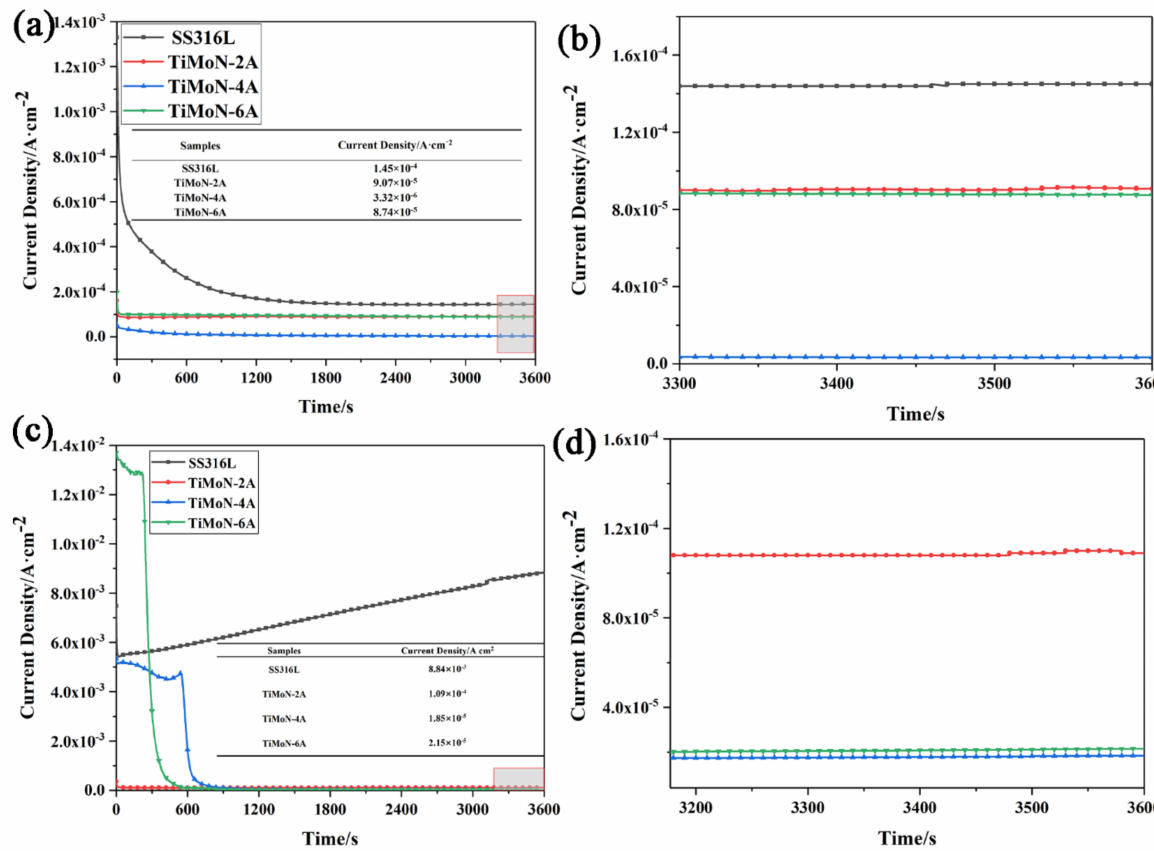
Figure 6. The high-potential polarization curves of SS316L and TiMoN coatings under a simulated PEMFC cathode environment. ( a ) 1.0 V SCE , ( b ) 1.0 V SCE enlarge image, ( c ) 1.2 V SCE , ( d ) 1.2 V SCE enlarge